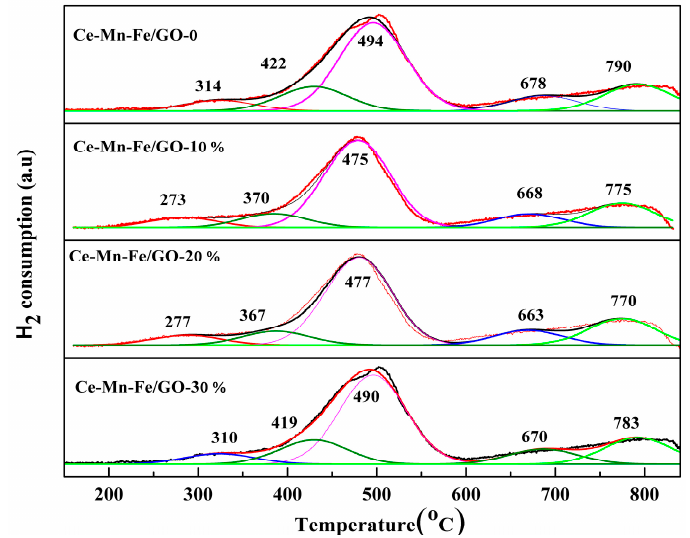
Figure 4. TPR profiles of the Ce-Mn-Fe/GO-x (x = 0, 10%, 20%, 30%) samples.